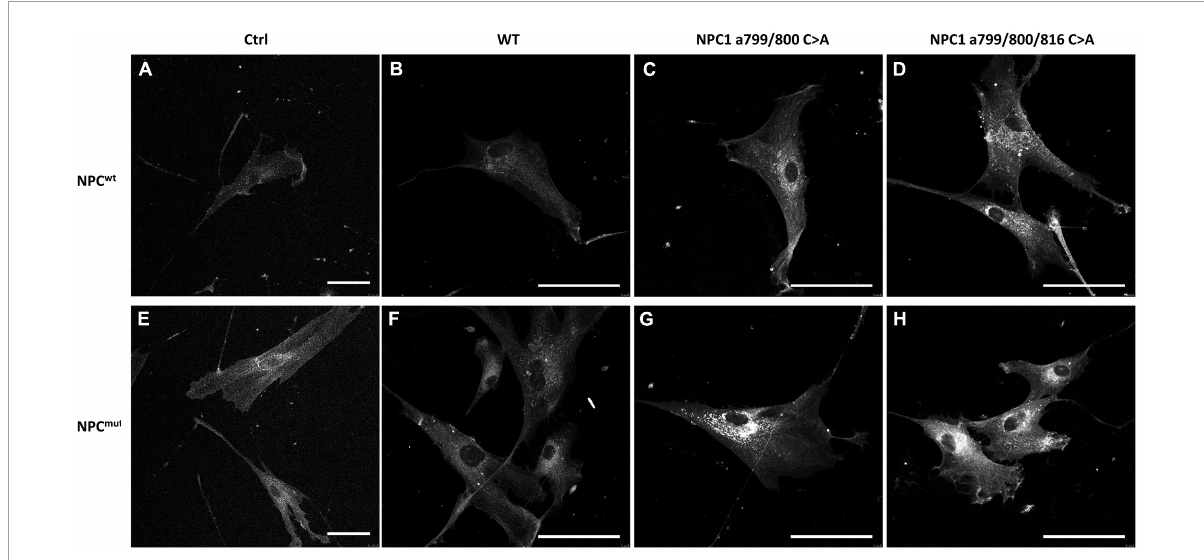
FIGURE6 Filipin staining of intracellular cholesterol in NPC1 wt (Top panels A–D ) and NPC1 mut fibroblasts (Bottom panels E–H ) transfected with wildtype (WT NPC1) and mutated NPC1 proteins as indicated. The introduction of wildtype NPC1 protein alleviated cholesterol accumulation in NPC1 mut cells (Panel F ). The introduction of double and triple-mutated NPC1 caused significant cholesterol accumulation in both cells (Panels C,D,G,H ). The scale bar denotes 50 µ